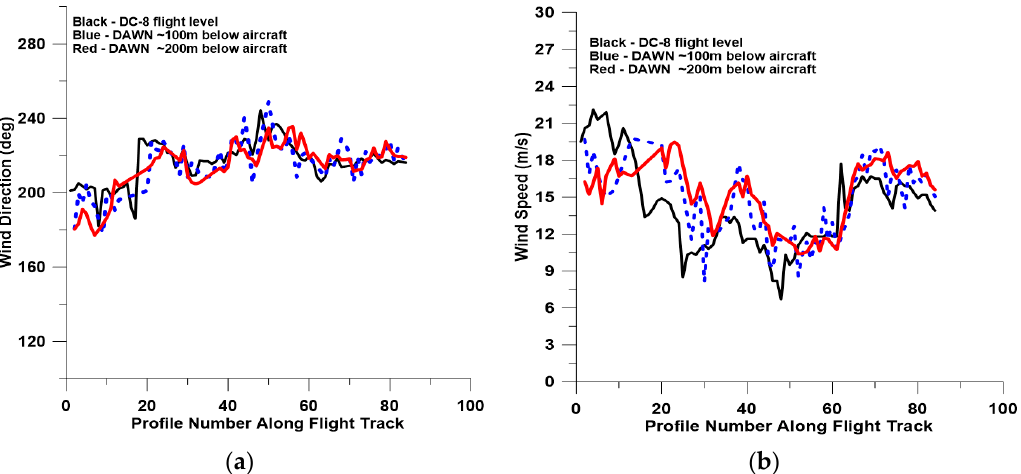
Figure 11. Wind direction ( a ) and wind speed ( b ) for DC-8 flight level observations and DAWN profile observation 100 and 200 m below the aircraft. Table 11. Closest to surface observations of wind speed (WS in m / s)) and wind direction (WD in deg) for DAWN and dropsondes compared to NDBC buoy measurements at 10